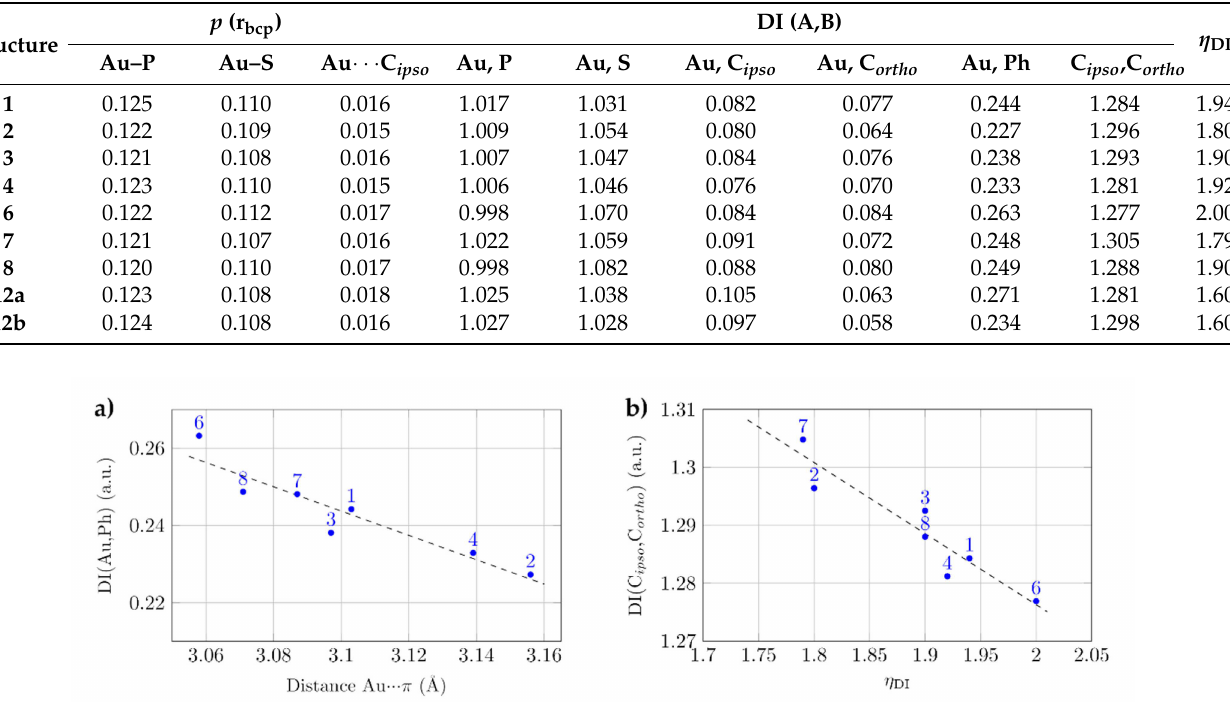
Figure 3. ( a ) Linear correlation of the distance of the gold atom to the capping phenyl ring plane (Au · · · π ) with the sum of DIs of Au with the carbons atoms that comprise the phenyl ring. ( b ) Decrease of the DI in the C ipso –C ortho bond resulting from the increase in the hapticity of the Au · · · π